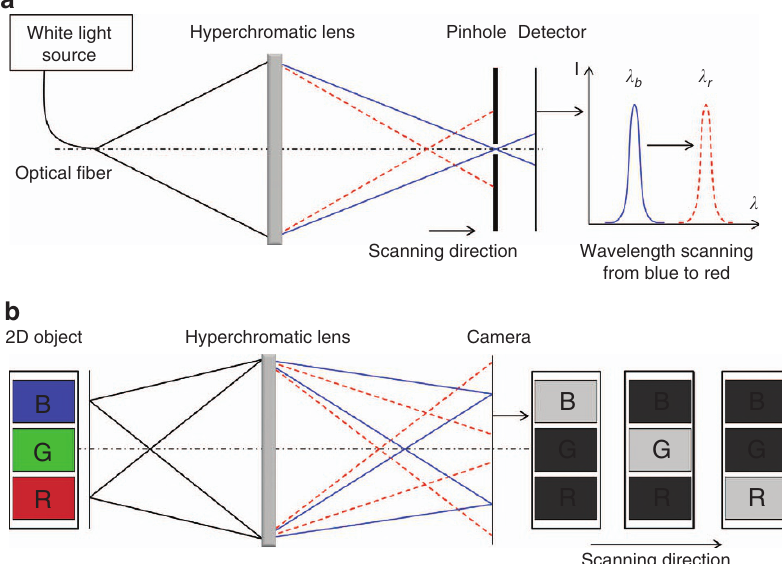
Figure 2 Working principles of a tunable hyperchromatic lens used for: ( a ) chromatic confocal sensing and ( b ) hyperspectral imaging. In a , a pinhole is placed in the image plane for spatial spectral fi ltering while the tunable lens is used for the wavelength scanning. Before tuning: the blue wavelength is focused on the pinhole and appears as a narrow spectral band on the detector; after tuning: the red wavelength is in focus on the pinhole so the spectral signal moves to the red wavelength. In b an object including red/green/blue parts is imaged by a hyperchromatic lens. The blue part is in focus while others are strongly blurred due to the high chromaticity; by tuning the lens, the green and red parts sequentially appear in focus on the